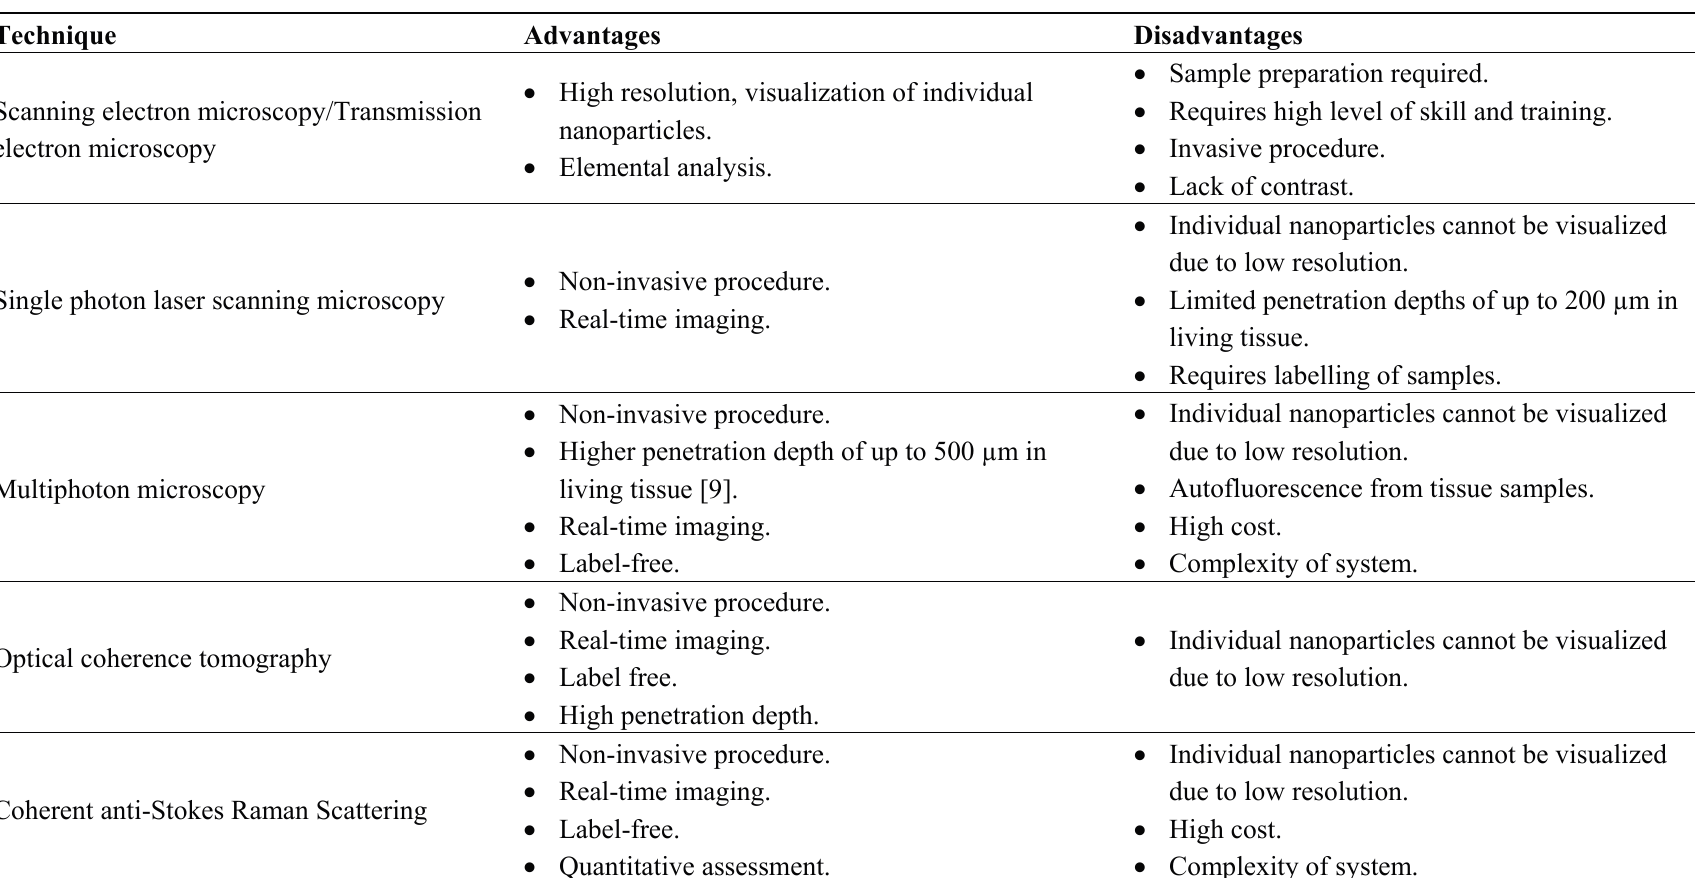
Table 1. Advantages and disadvantages of imaging techniques for nanoparticles associated with cosmetic and skin